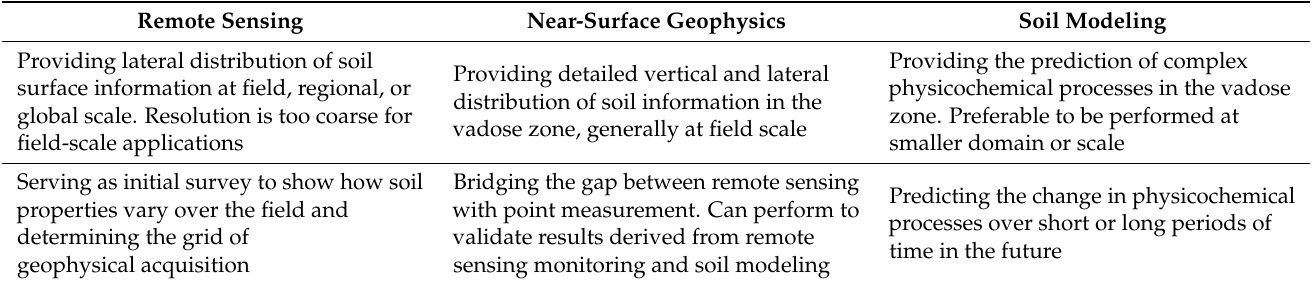
Table 4. Comparison of remote sensing, near-surface geophysics, and soil